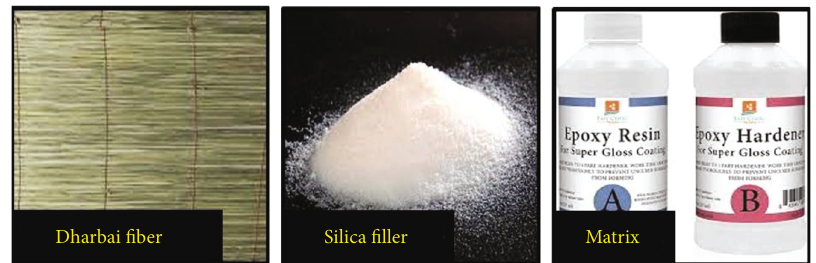
Figure 1: Photographic image of reinforcement, fi ller, and matrix